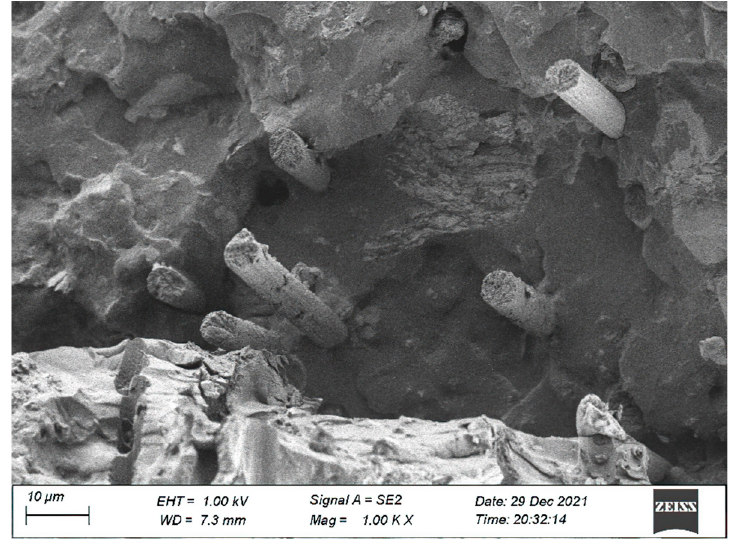
Figure 19. A 10 μ m SEM micrograph. Figure 19. A 10 µ m SEM